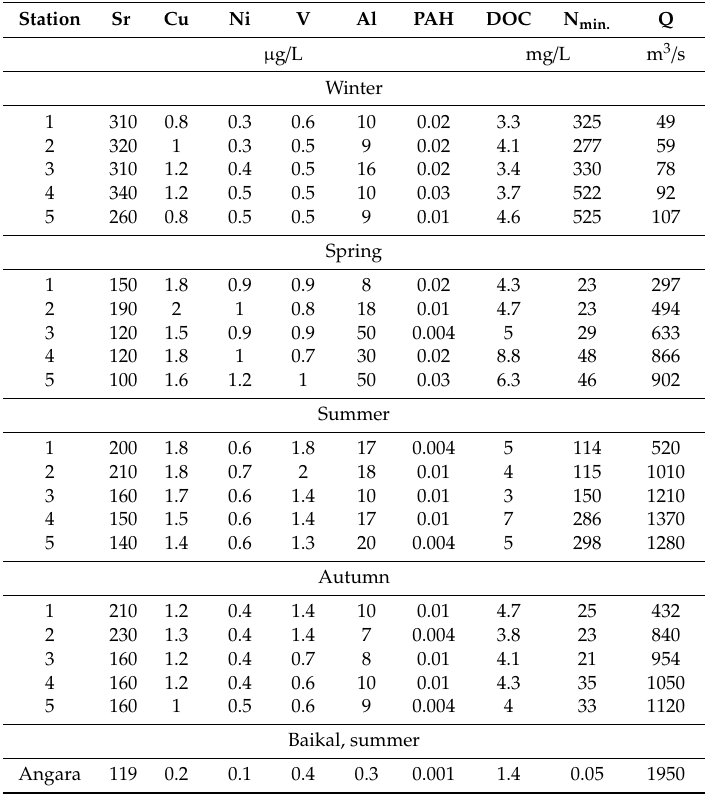
Table 2. Average chemical composition and water discharge of the Selenga River and Lake Baikal.